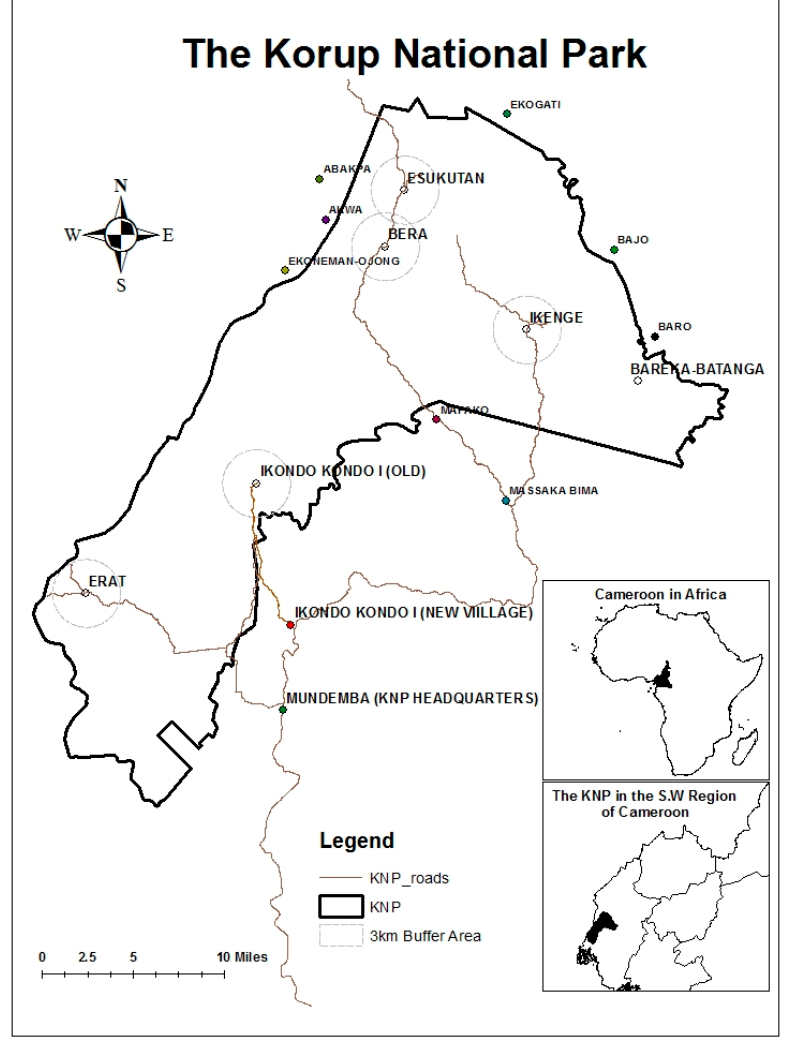
Figure 1. The Korup National Park in Cameroon. Created by Siewe Siewe. Source: Shapefiles for Cameroon and Africa (ArcGIS database).